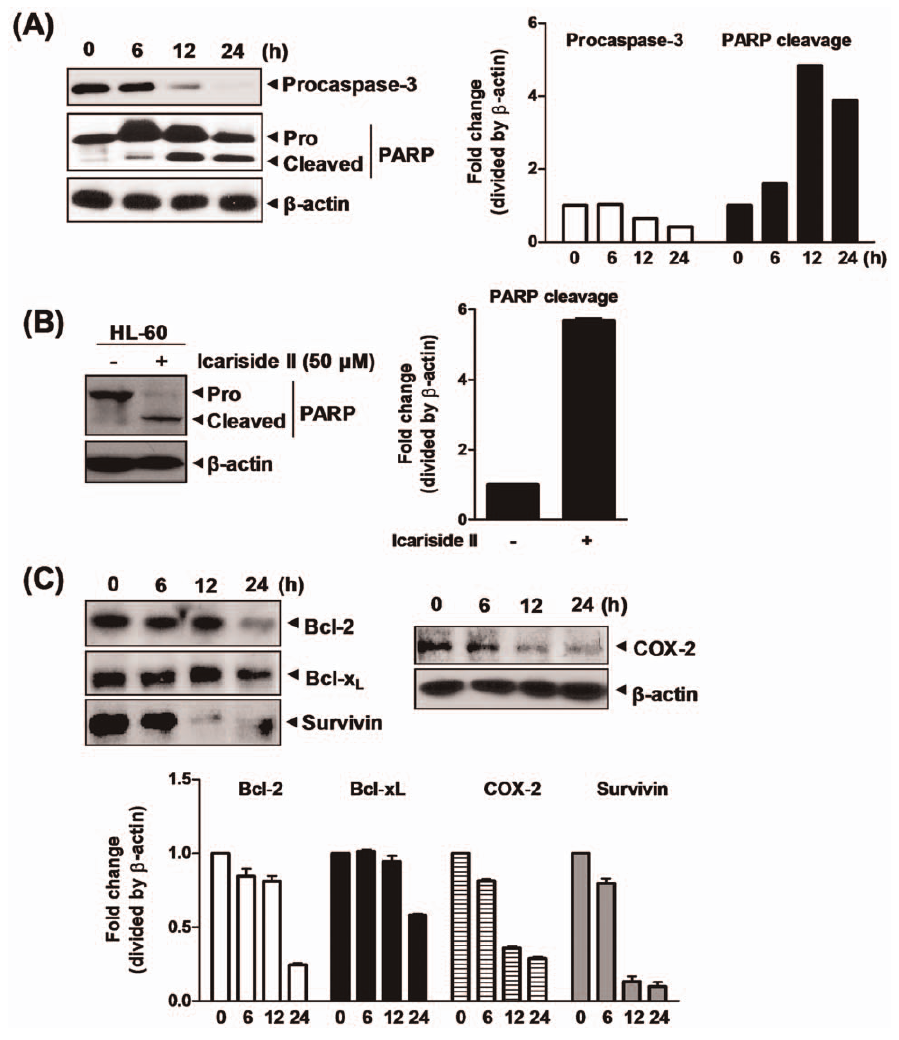
Figure 3. Effect of Icariside II on apoptosis-related proteins in U937 cells. (A) U937 cells were treated with Icariside II (50 m M) for 0, 6, 12 or 24 h. Cell lysates were prepared and subjected to Western blotting for procaspase-3 and PARP. (B) HL-60 cells were treated with or without Icariside II (50 m M) for 24 h. Western blot analysis was performed for PARP. (C) U937 cells were treated with Icariside II (50 m M) for 0, 6, 12 or 24 h. Western blotting was performed for bcl-2, bcl-x L , survivin and COX-2. Representative results of three independent experiments are shown for each experiment.